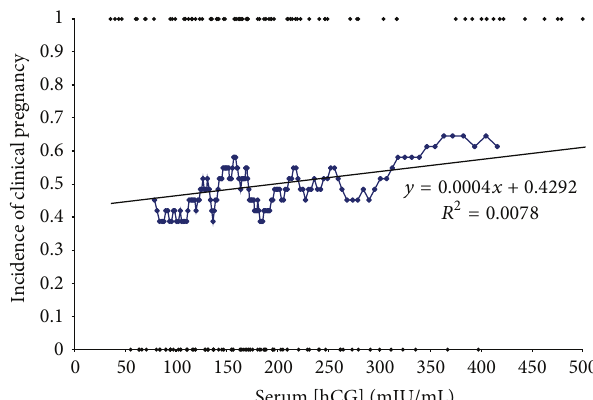
Figure 2: Postovulatory serum hCG level and pregnancy rate. The incidence of pregnancy was 50%. Serum hCG levels the morning after ovulatory injection did not correlate with incidence of clinical pregnancy( 𝑅 = 0.088 ).Patientswhowerepregnantwereconsidered a value of 1 and patients who were not pregnant were considered a value of 0. Straight line is the regression line for all patients. The blue tracing displays a rolling average of the